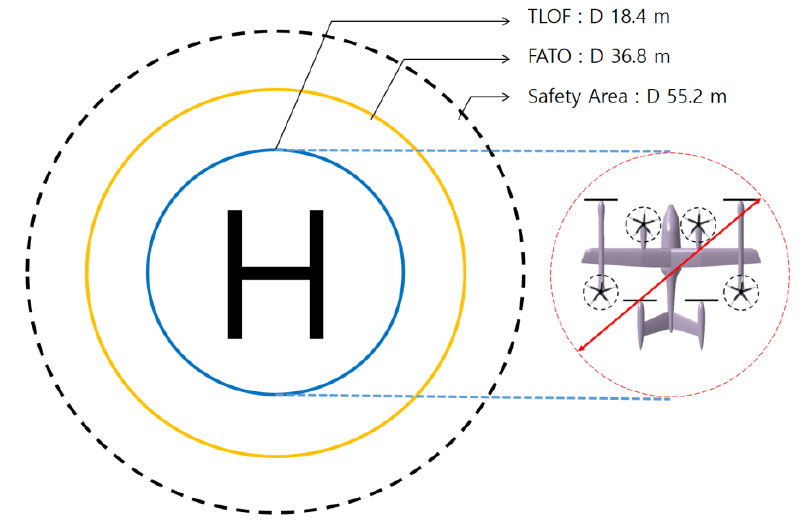
Figure 2. Vertipad size for S- A1 that comply with the FAA’s new regulatio ns.